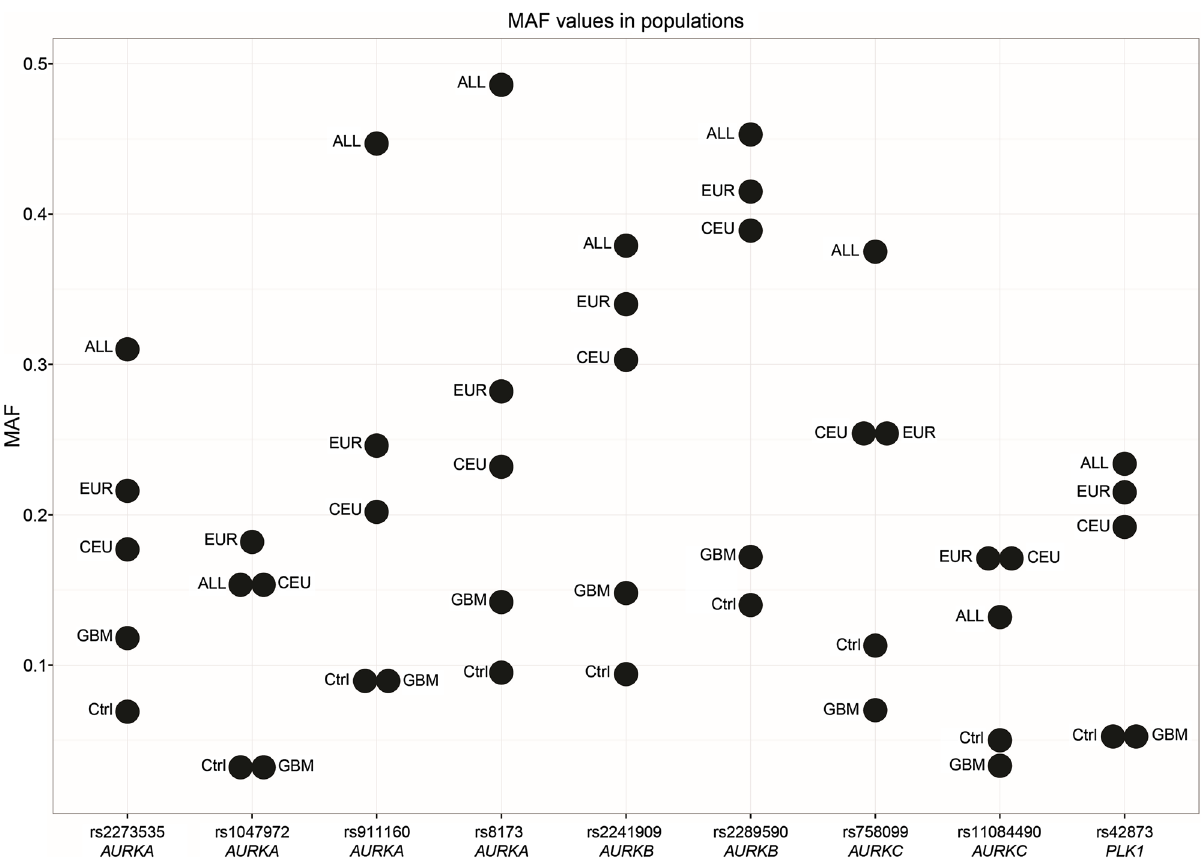
Figure 2. Minor allele frequencies (MAFs) for polymorphisms rs1047972, rs2273535, rs8173 and rs911160 ( AURKA ), rs2289590 and rs2241909 ( AURKB ), rs11084490 and rs758099 ( AURKC ) and rs42873 ( PLK1 ) in various populations. ALL all individuals from 1000 Genome Project Phase 3 release, Ctrl studied control population, CEU Utah residents with Northern and Western European ancestry, EUR European population, GBM studied glioblastoma multiforme group, MAF minor allele